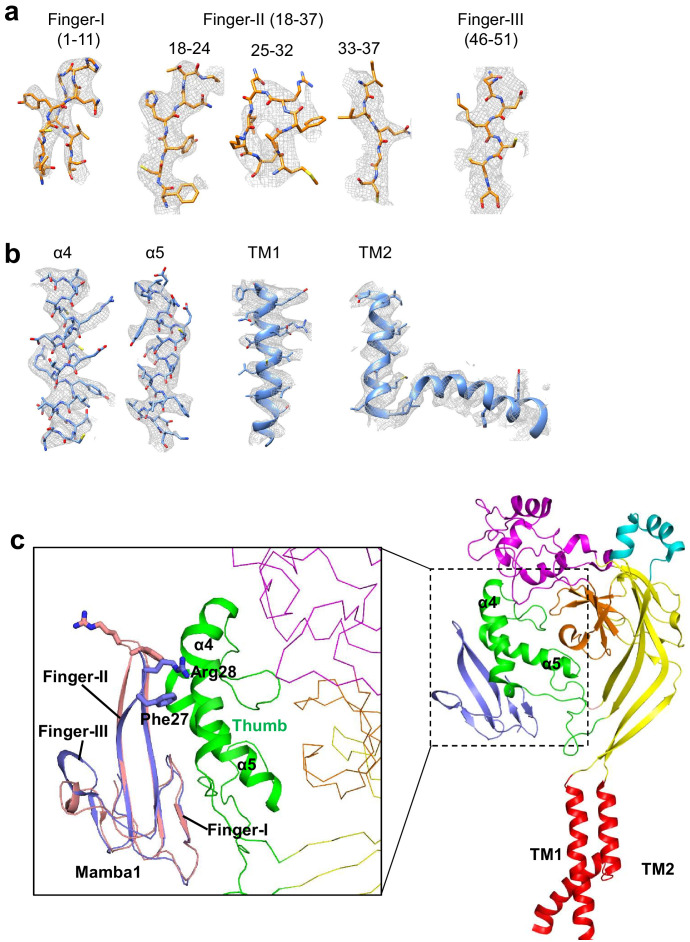
Structure model building of hASIC1aΔC-Mamba1 complex.(a–b) Representative density maps of the secondary structure elements of the Mamba1 (a) and hASIC1aΔC (b). (c) Cartoon representation of a single subunit of the hASIC1aΔC-Mamba1 complex. Each domain are show in different color. Insert shows conformation change of Mamba1 after binding to hASIC1a. Structure comparison indicates the tip region of Finger II of Mamba1 flips to the thumb domain of hASIC1a. Apo form Mamba1 is colored in light pink (PDB 5DZ5). The Mamab1 and the thumb domain of hASIC1a in the hASIC1aΔC-Mamba1 complex are colored in light blue and green, respectively.